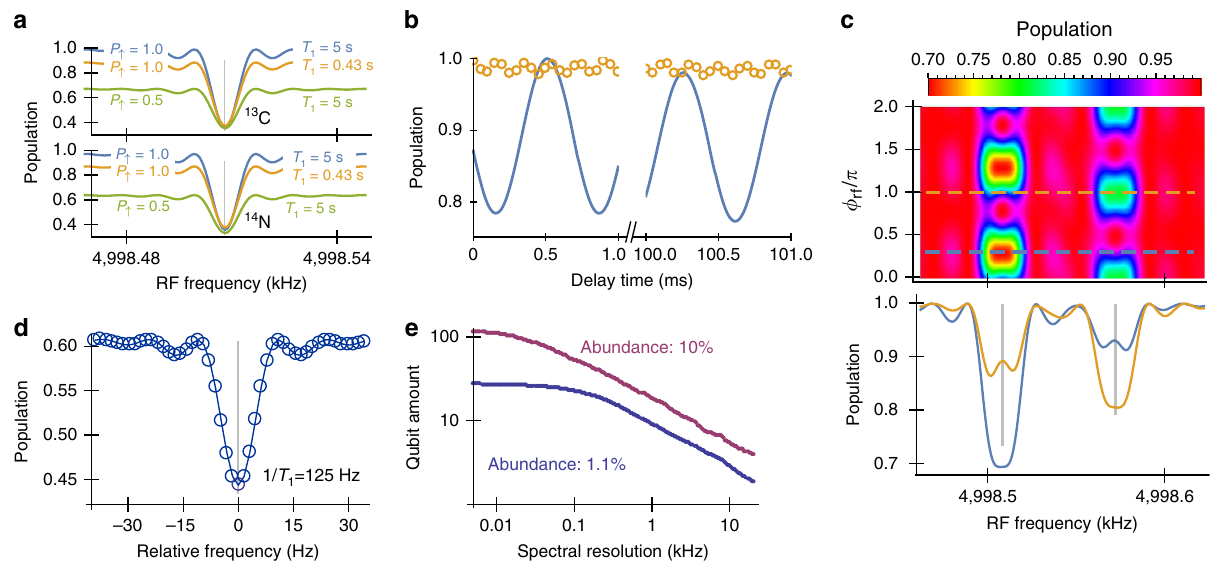
Figure 4 | Delayed entanglement echo by using a nuclear memory qubit. ( a ) Signal dips when addressing to a single distant 13 C nuclear spin E 2.2nm away from the NVcentre by storing the qubit state in a 13 C or in the intrinsic 14 N memory qubit during the delay windows, for t rf ¼ 100ms, t ¼ 100 m s, and various low-temperature electron spin relaxation times T 1 and initial populations P m of the memory qubit state "j i . ( b ) Population modulation (solid line) caused by two interacting 13 C nuclei in a C–C bond B 1.5nm away from the NV centre with t ¼ 200 m s and a 14 N memory. Application of LG decoupling suppresses nuclear dipolar coupling and hence the modulation (circles). ( c ) Signal patterns from two uncoupled distant 13 C spins (2.2 and 2.3nm away from the NVcentre) when using a 14 N memory qubit and DD to protect the interaction windows of duration t ¼ 500 m s. The cross-sectional plots show the signals in the two-dimensional plot (dashed lines) when the initial RF phases f rf match the azimuthal angles of addressed nuclear spins. ( d ) Room- temperature signal of one proton spin placed 4nm away from the NV centre using a 13 C memory qubit and optical illumination during the delay window (Supplementary Note 5). With the RF driving of t rf E 10 T 1 , the line-width of the signal is well beyond the limit set by electron spin relaxation time 1/ T 1 . One major reason of the reduction of signal contrast is the leakage out from the electron qubit to another electron spin triplet level. ( e ) Log-log plot of the average number of individual 13 C register qubits with A jj = ð 2 p Þ 4 4 kHz and A jj = ð 2 p Þ different from other spins by amounts larger than the spectral j j resolution, by averaging over 1000 samples. A magnetic field is used for the bare Larmor frequency o 13 ¼ 2 p (cid:10) 5MHz. In a , d , c , y rf ¼ p , and y rf ¼ 0 in b . In C a , b , the electron qubit state # e j i¼ 0 j i is transferred to # e j i¼ (cid:3) 1